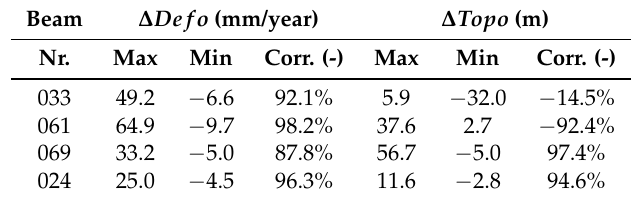
Table 5. Summary of statistical analysis of the differences of two PSI processing results without and with tropospheric delay correction: maximum and minimum value of deformation differences and residual topography differences as well as their correlation with height. An offset compensation has been performed on both differences in order to account for the different reference